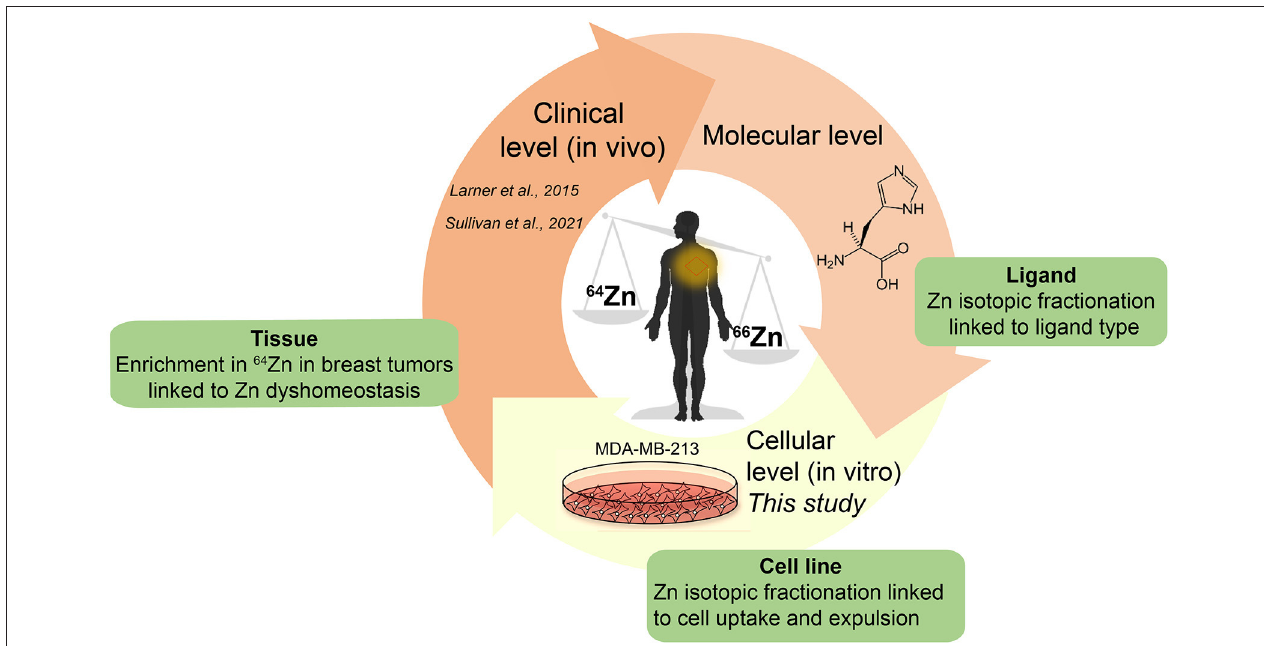
FIGURE 1 | Schematic of overall approach for biomedical studies to investigate metal stable isotope